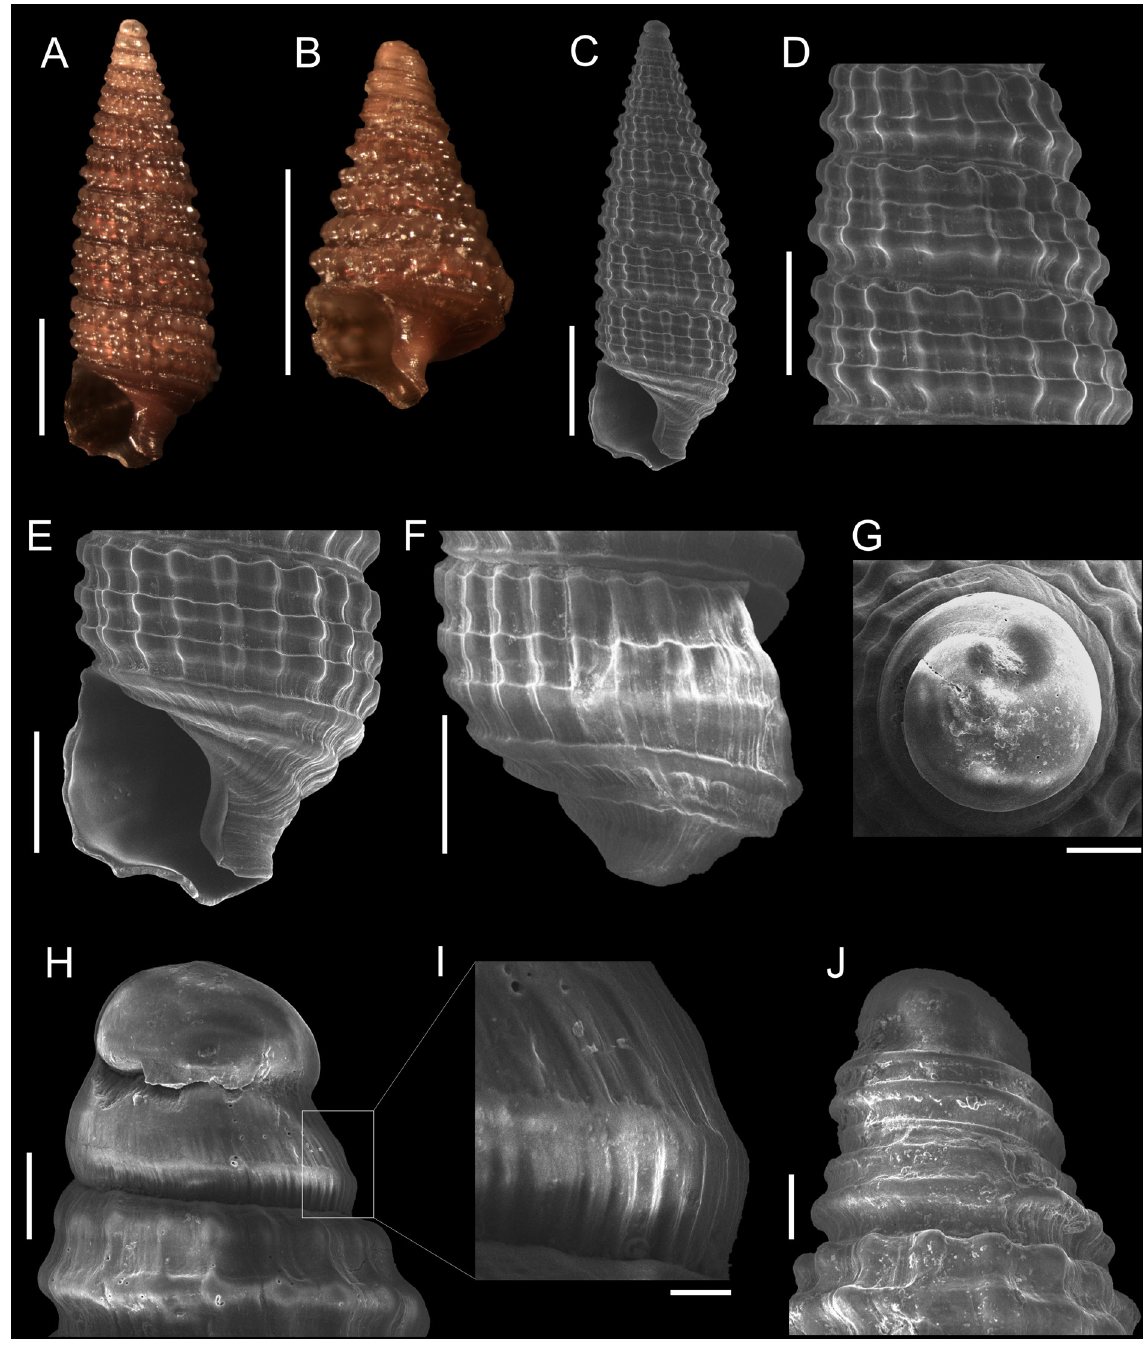
Fig. 9. Marshallora sp. 1. A–B. MZSP 63331*, 4.00 mm and 1.65 mm, respectively. C–I . Same shell as A. J . Same shell as B. Scale bars: A–C = 1 mm; D–F = 500 µm; G–H, J = 100 µm; I = 20 µm